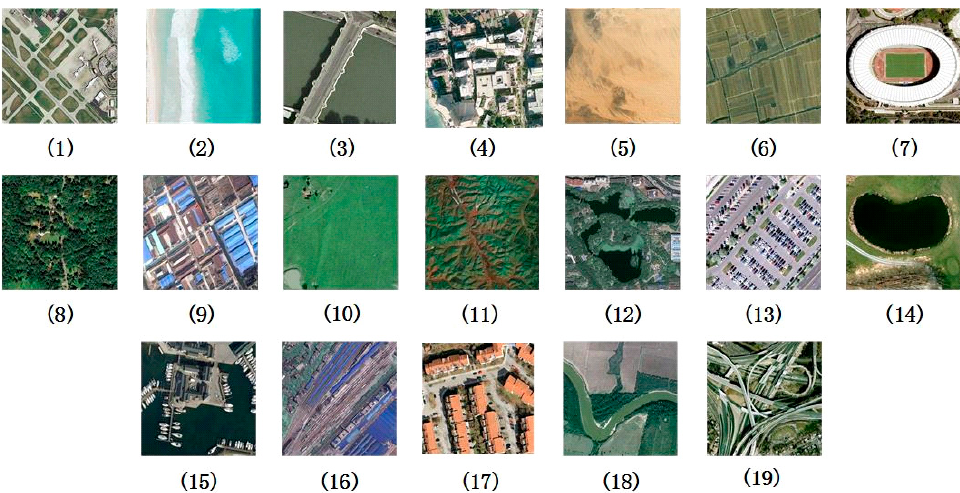
Figure 8. Examples from the 19-class satellite scene dataset: ( 1 ) airport; ( 2 ) beach; ( 3 ) bridge; ( 4 ) commercial; ( 5 ) desert; ( 6 ) farmland; ( 7 ) football field; ( 8 ) forest; ( 9 ) industrial; ( 10 ) meadow;